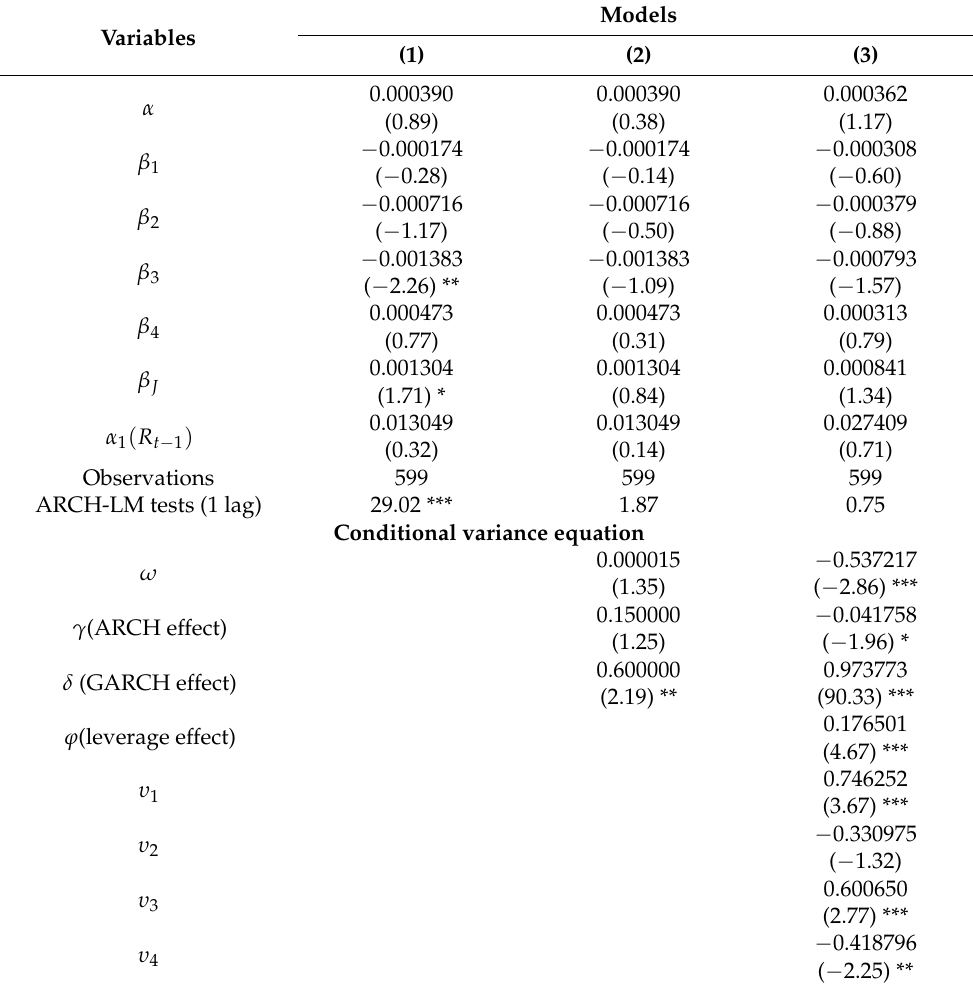
Table 7. Empirical findings for the post-index future